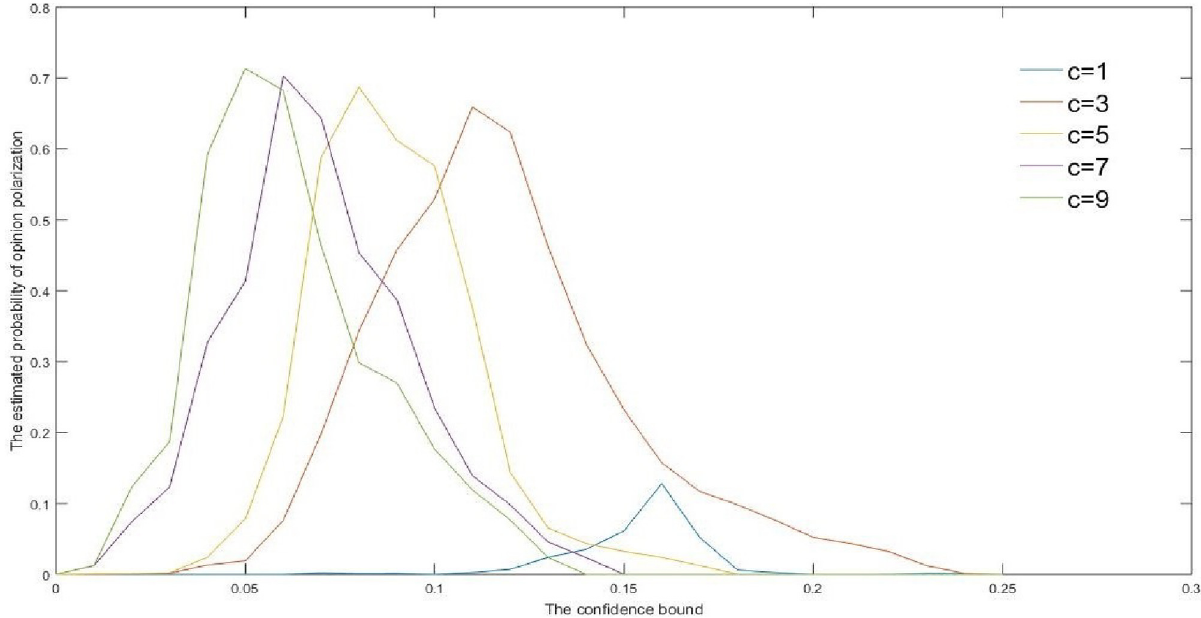
Fig 3. The probability of opinion polarization as the confidence bound